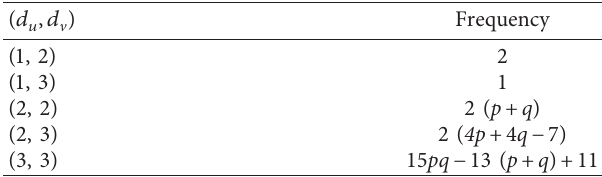
Table 2: Partition of E ( Si